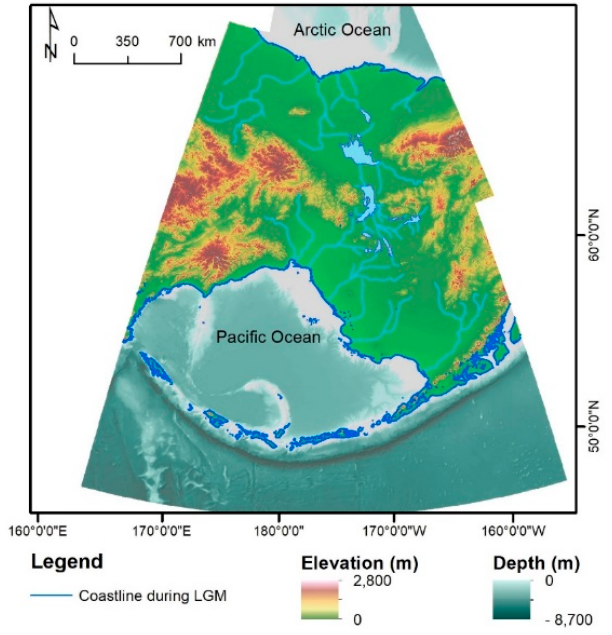
Figure 6. The Bering land bridge during the LGM (modified after Bond [179]).